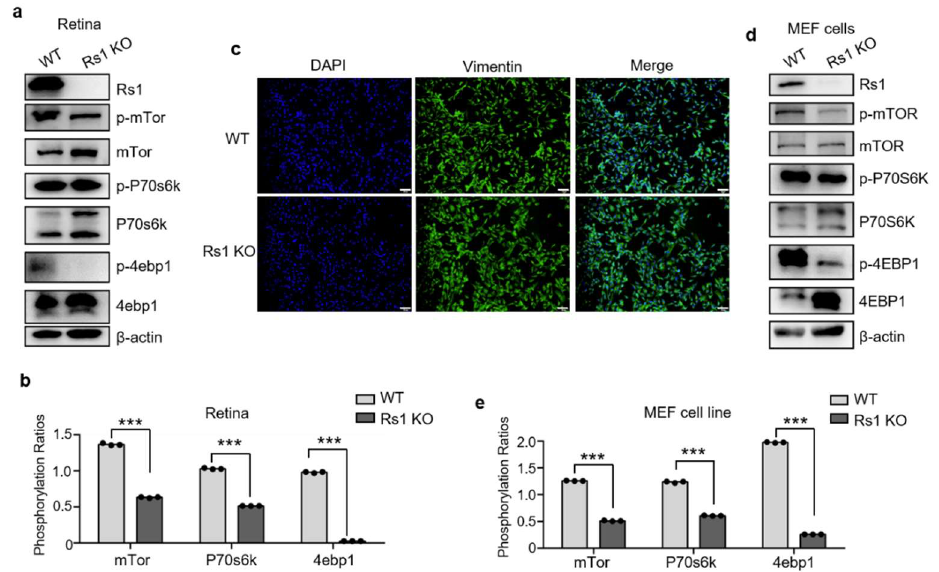
Figure 4. Validation of the Tor signaling pathway. ( a ) WB analysis of XLRS retinas at P56. ( b ) Statistical histogram of relative gray value of proteins in ( a ). ( c ) Immunofluorescence images of MEF cells. DAPI fluorescence (blue) marking the cell nuclei. Vimentin (green), an antibody specific for MEF cells, were used to validate the purity of MEF cell lines. Bar represents 100 µm. ( d ) WB analysis of MEF cells derived by WT (left) or RS1 KO (right) mouse. ( e ) Statistical histogram of relative gray value of proteins in ( d ). WB results were quantified using ImageJ software (Version 1.52a, NIH, Bethesda, MD, USA) and are presented as ratios of the grey value (phosphorylation of target protein vs. target protein). Differences between groups were assessed by one-way ANOVA. ***, p < 0.001.